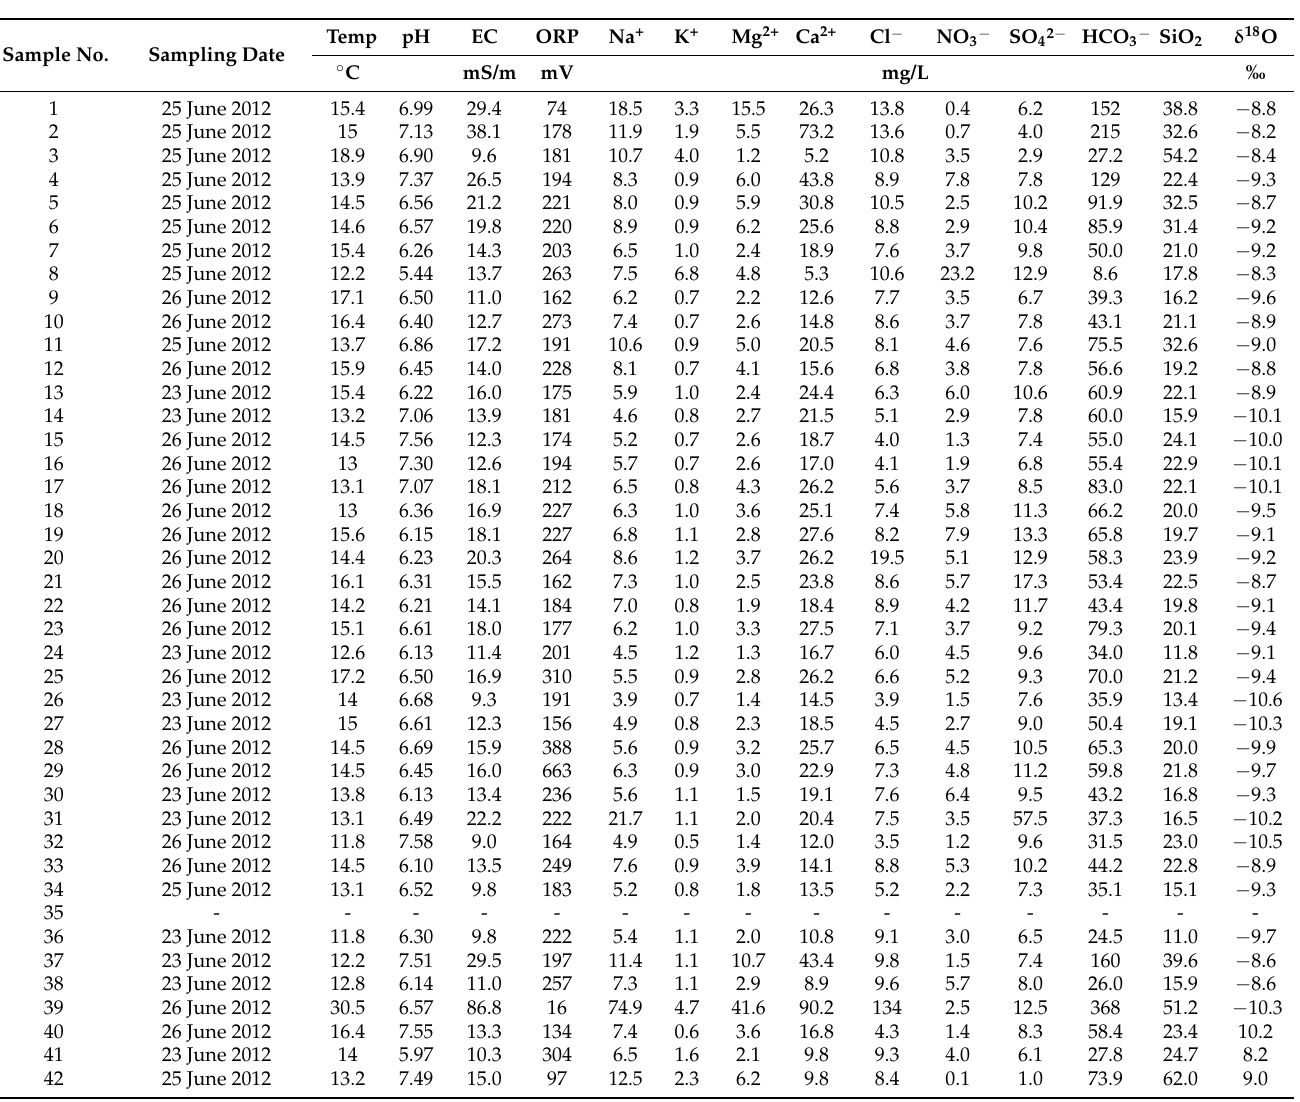
Table 5. Water temperature, pH, electric conductivity (EC), oxidation–reduction potential (ORP), chemical, and δ 18 O composition for groundwater samples in the Sho River alluvial fan on 23 June to 26 June 2012. Sample